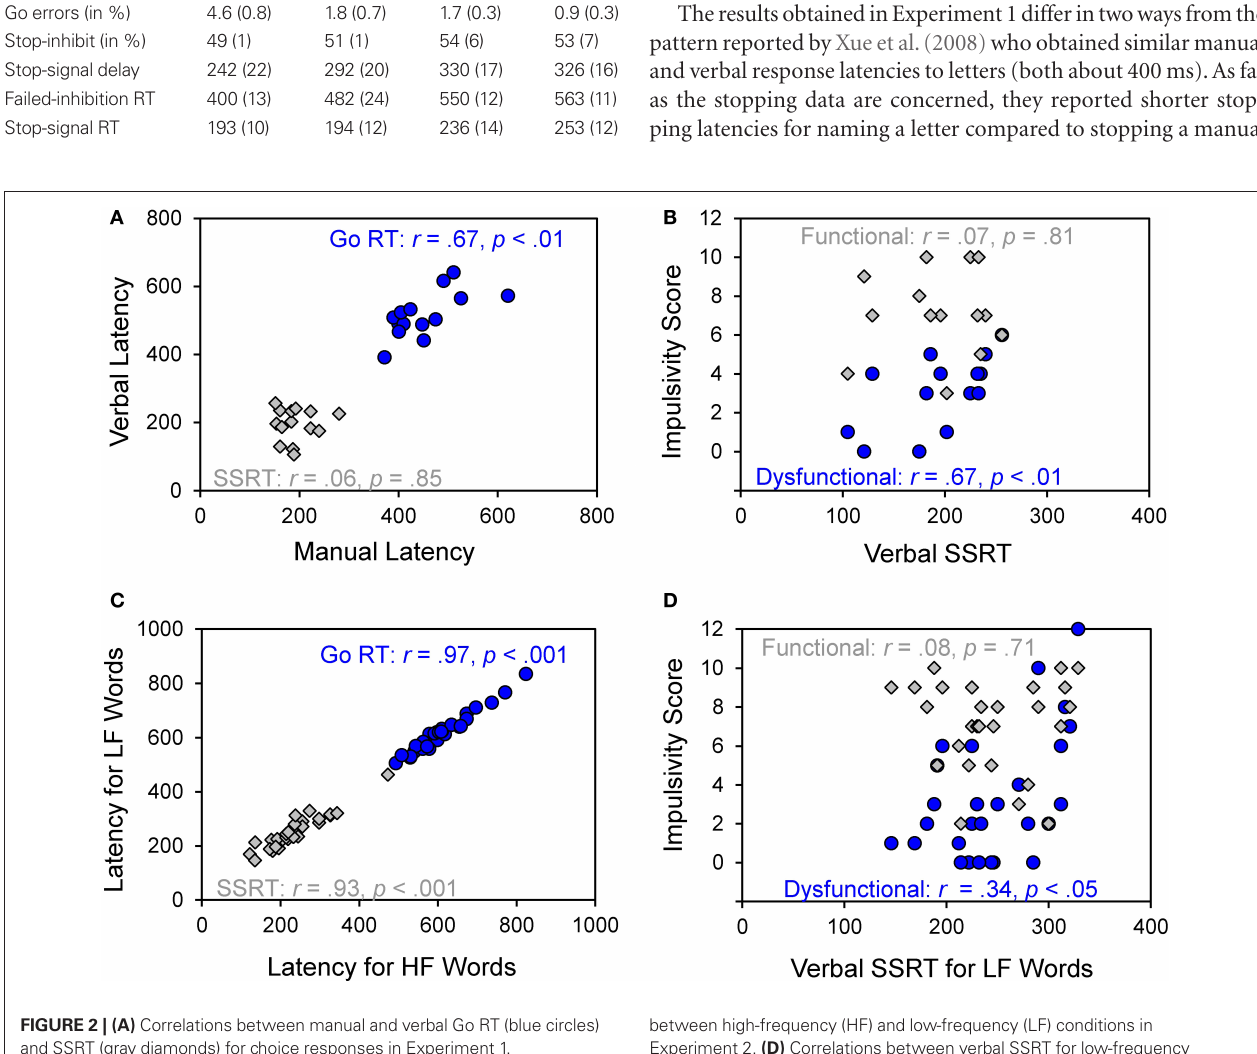
between high-frequency (HF) and low-frequency (LF) conditions in Experiment 2. (D) Correlations between verbal SSRT for low-frequency (LF) words and impulsivity scores (functional impulsivity scores in gray diamonds; dysfunctional impulsivity scores in blue circles) in Experiment